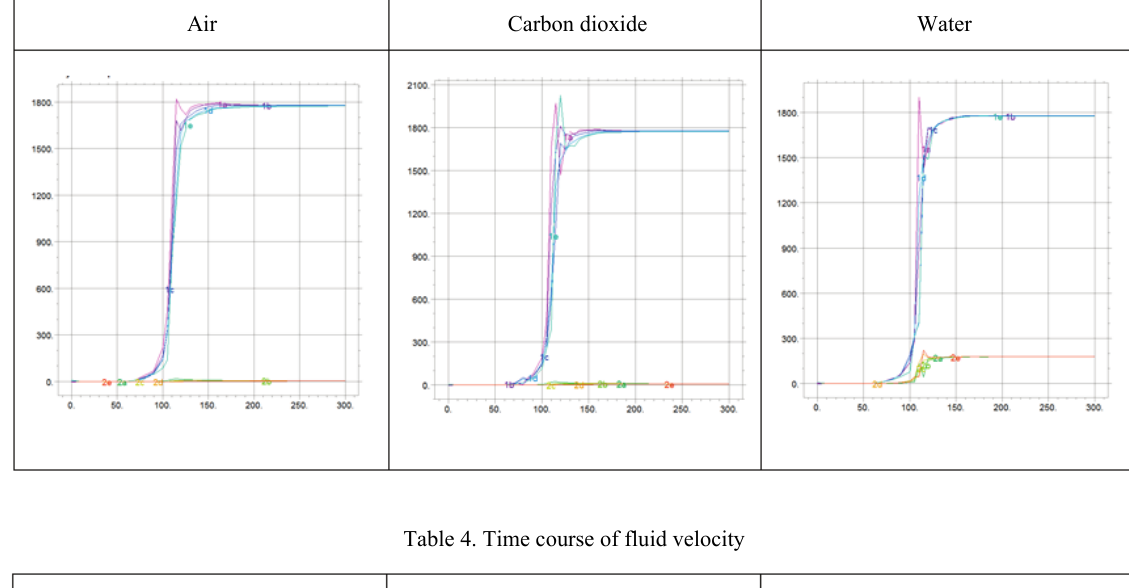
Table 3. Time course of the quantity of heat flowing through the skeleton and the pore fluid